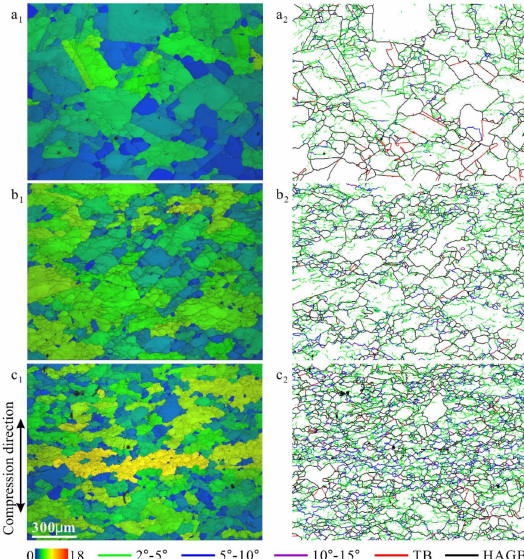
Figure 2. Microstructures of 18Mn18Cr0.6N steel compressed at 10 − 4 s − 1 and a cooling rate 0.0125 Ks − 1 to different strains: 0.2 ( a 1 , a 2 ), 0.4 ( b 1 , b 2 ), and 0.8 ( c 1 , c 2 ). ( a 1 ), ( b 1 ), and ( c 1 ) are band contrast images overlaid by grain orientation spread images; ( a 2 ), ( b 2 ), and ( c 2 ) are grain boundary characteristic distribution images. The vertical direction is the compression direction.